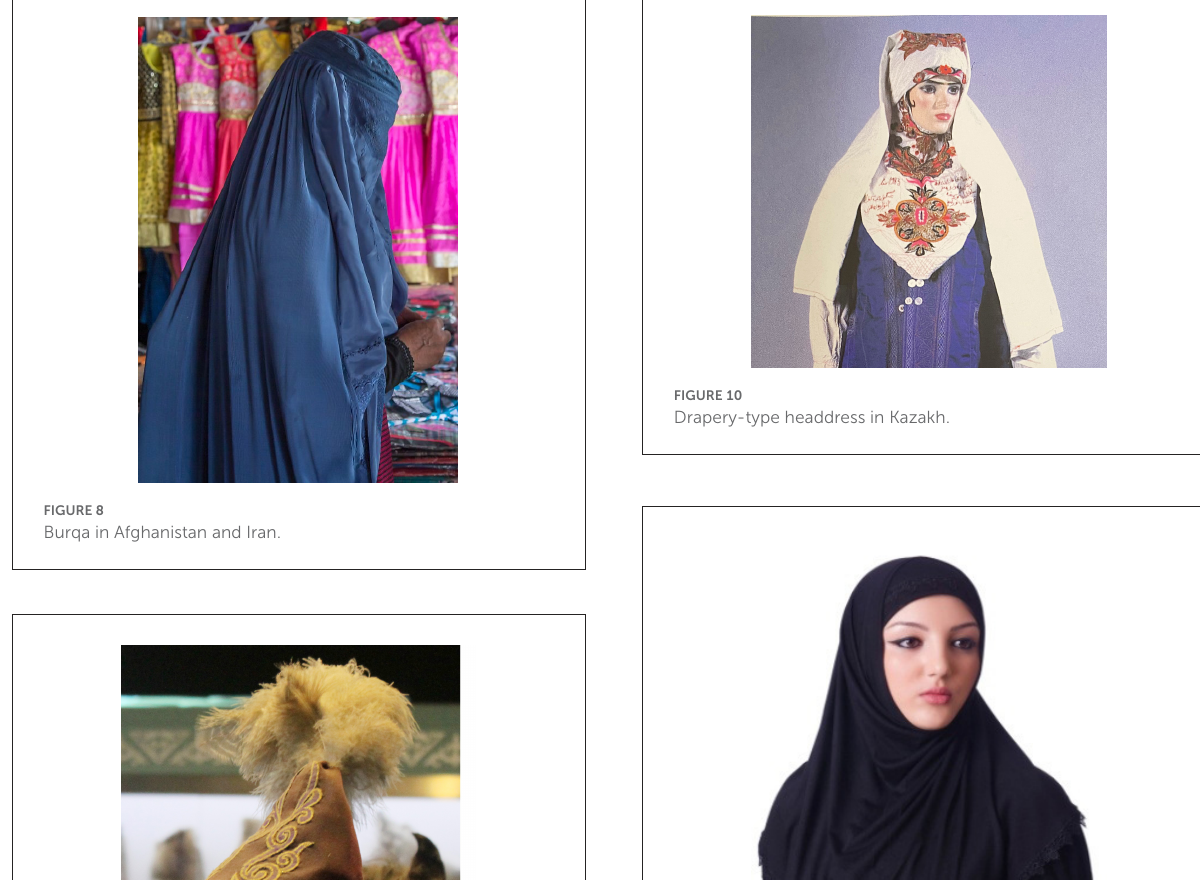
FIGURE11 Drapery-type headdress in